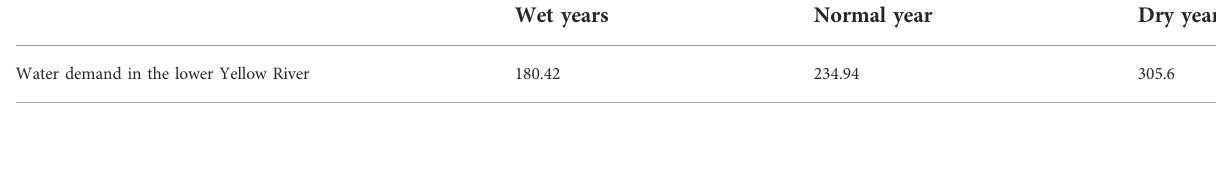
TABLE 4 Water demand in the lower Yellow River/10 8 m 3 .